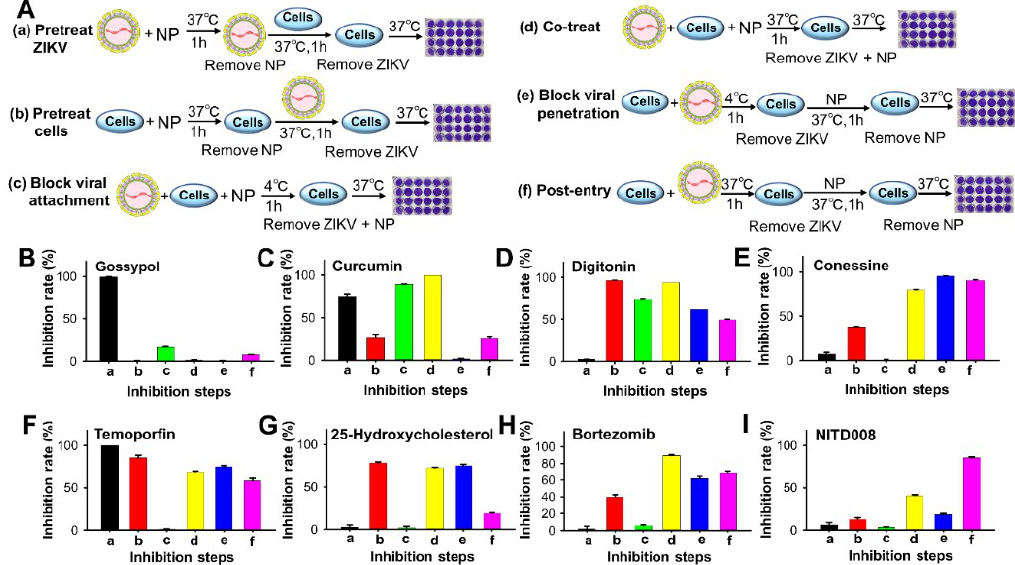
Figure 3. Time-of-addition experiment to test the ability of natural products to block ZIKV infection at different steps of the viral life cycle [21]. ( A ) The time-of-addition experiment was performed in Vero E6 cells, and specific procedures are illustrated in detail in ( a – f ). ( a ) Pretreatment of ZIKV: ZIKV was incubated with one of the natural products (NPs; including gossypol, curcumin, digitonin, and conessine) at 37 °C for 1 h. After removal of the unbound NPs, the NP-treated ZIKV was incubated with cells at 37 °C for 1 h, followed by culture of the cells at 37 °C for 4–5 days before calculation of plaques. ( b ) Pretreatment of cells: cells were preincubated with one of the NPs at 37 °C for 1 h, and the unbound NPs were then removed, followed by addition of ZIKV and incubation of cells at 37 °C for 1 h. After removal of the unbound ZIKV, the cells were cultured and plaques were calculated as in ( a ). ( c ) Blockage of ZIKV attachment: cells were incubated with ZIKV at 4 °C for 1 h to allow ZIKV attachment, but not fusion between ZIKV and cell membranes, in the presence of one of the NPs. After removal of the unbound ZIKV and NPs, the cells were cultured and plaques were calculated as in ( a ). ( d ) Cotreatment of ZIKV and cells: cells were infected with ZIKV at 37 °C for 1 h in the presence of one of the NPs, followed by removal of the unbound viruses and NPs, and culture of the cells to calculate plaques, as in ( a ). ( e ) Blockage of ZIKV penetration (membrane fusion): cells were incubated with ZIKV at 4 °C for 1 h to allow ZIKV attachment. After removal of the unbound ZIKV, the cells were incubated with one of the NPs at 37 °C for 1 h to allow fusion of virus–cell membranes. After further removal of the unbound NPs, the cells were cultured and plaques were calculated as in ( a ). ( f ) Inhibition of postentry stage: cells were incubated with ZIKV at 37 °C for 1 h to allow ZIKV entry into the target cells. After removal of the unbound ZIKV, the cells were further incubated with one of the NPs at 37 °C for 1 h, followed by removal of the unbound NPs and culture of cells for calculation of plaques, as in ( a ). Inhibition of natural products, including gossypol ( B ), curcumin ( C ), digitonin ( D ), and conessine ( E ), against ZIKV (PAN2016) infection in the six steps mentioned above. ( F ) A potent anti-ZIKV inhibitor, temoporfin [28], was used as a control for step a. ( G ) An anti-ZIKV entry (especially in inhibition of the internalization/fusion step) inhibitor, 25-hydroxycholesterol [29], was used as a control for steps b and e. Anti-ZIKV compound bortezomib was used as a control for step d ( H ), and a replication inhibitor, NITD008 [30], for step f ( I ). The natural product curcumin ( C ), which has been previously reported to inhibit the attachment of ZIKV to host cells [37], was used as a control for stage c. The percent inhibition was calculated in the presence or absence of serially diluted natural products. The data are expressed as mean ± s.e.m. ( n = 2). The experiments were performed in Vero E6 cells and repeated three times, with similar results.